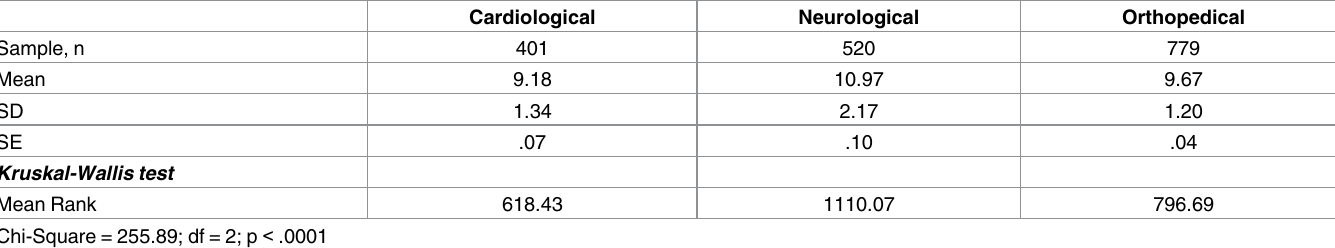
Table 4. Comparison of RCS-E v13 scores among the nosological categories of rehabilitation patients.